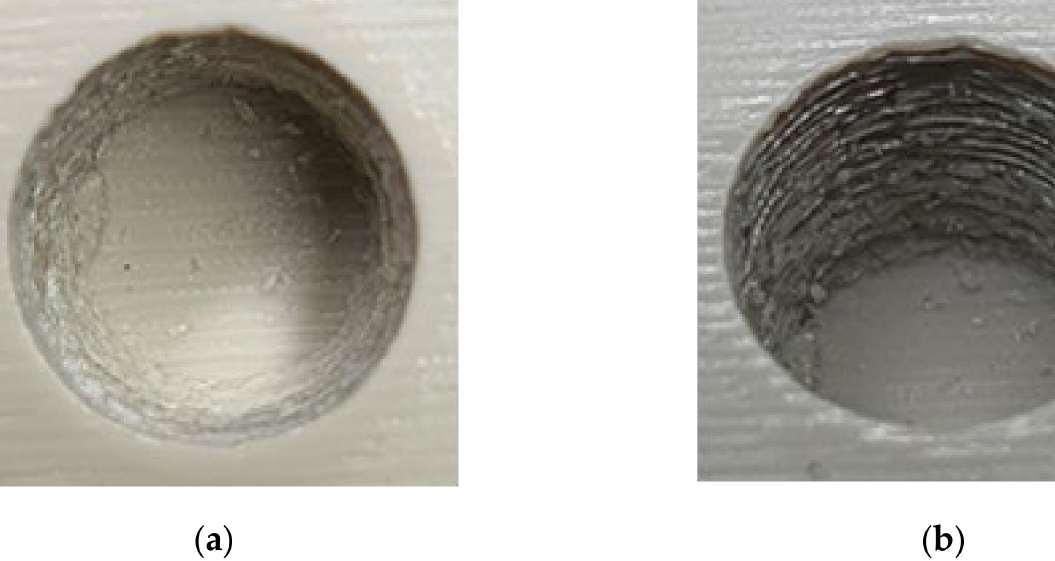
Figure 25. ( a ) Top view of M5 core on the pin on 5th part showing no signs of deterioration; ( b ) orthographic view of M5 core hole on 5th part showing no signs of